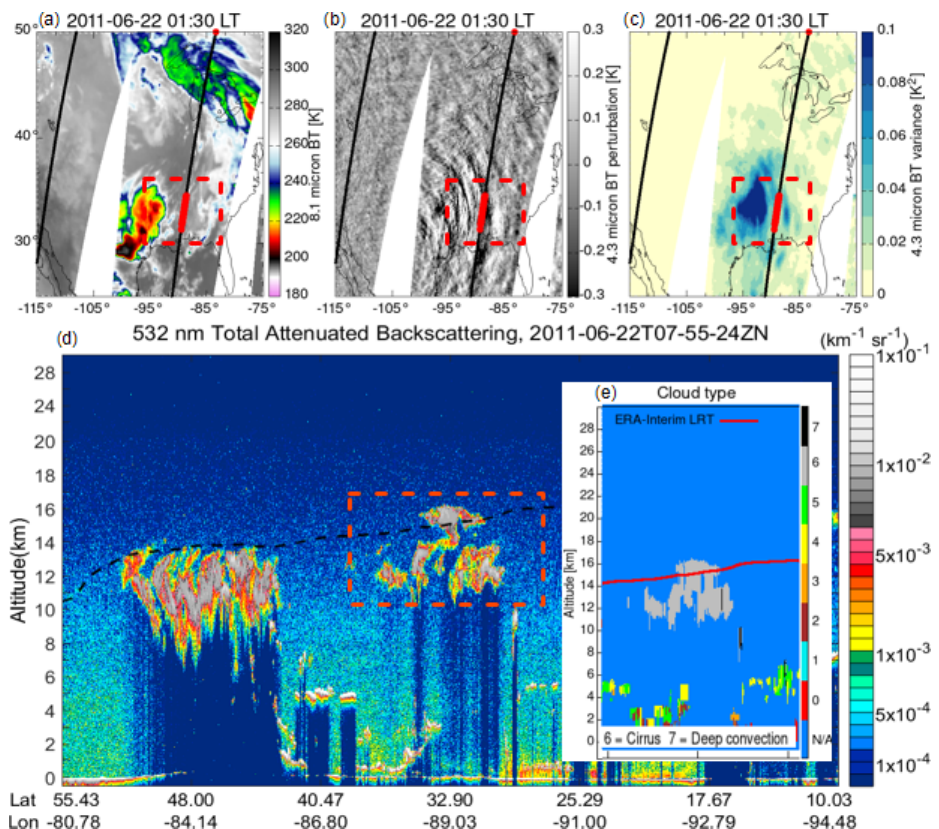
Figure 10. Example of relations between gravity waves and SICs. Panels (a–c) show brightness temperature, brightness temperature pertur- bations, and variances from AIRS measurements; brightness temperature variances in (c) with a threshold of 0.05K 2 identify stratospheric gravity waves. Red dots indicate SIC detections along CALIPSO orbits. Panel (d) shows vertical features of clouds from CALIPSO backscat- ter data. Panel (e) shows cloud type in the region of interest. The red curve shows the ERA-Interim